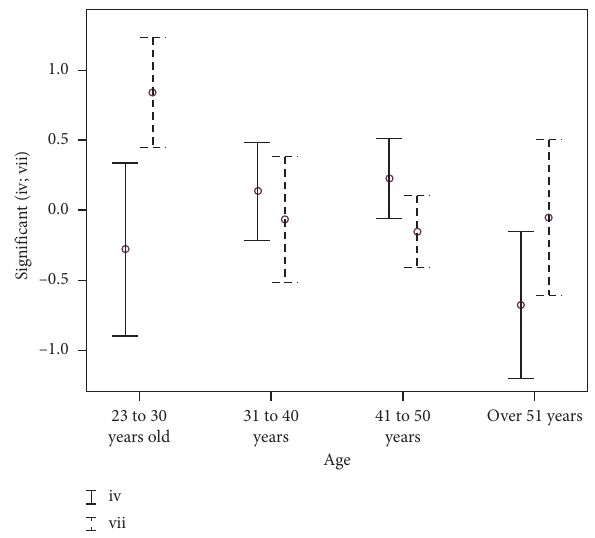
Figure 3: ANOVA technological links with the environment (iv), culture of innovation within the company/age, 95% least signifi- cance difference